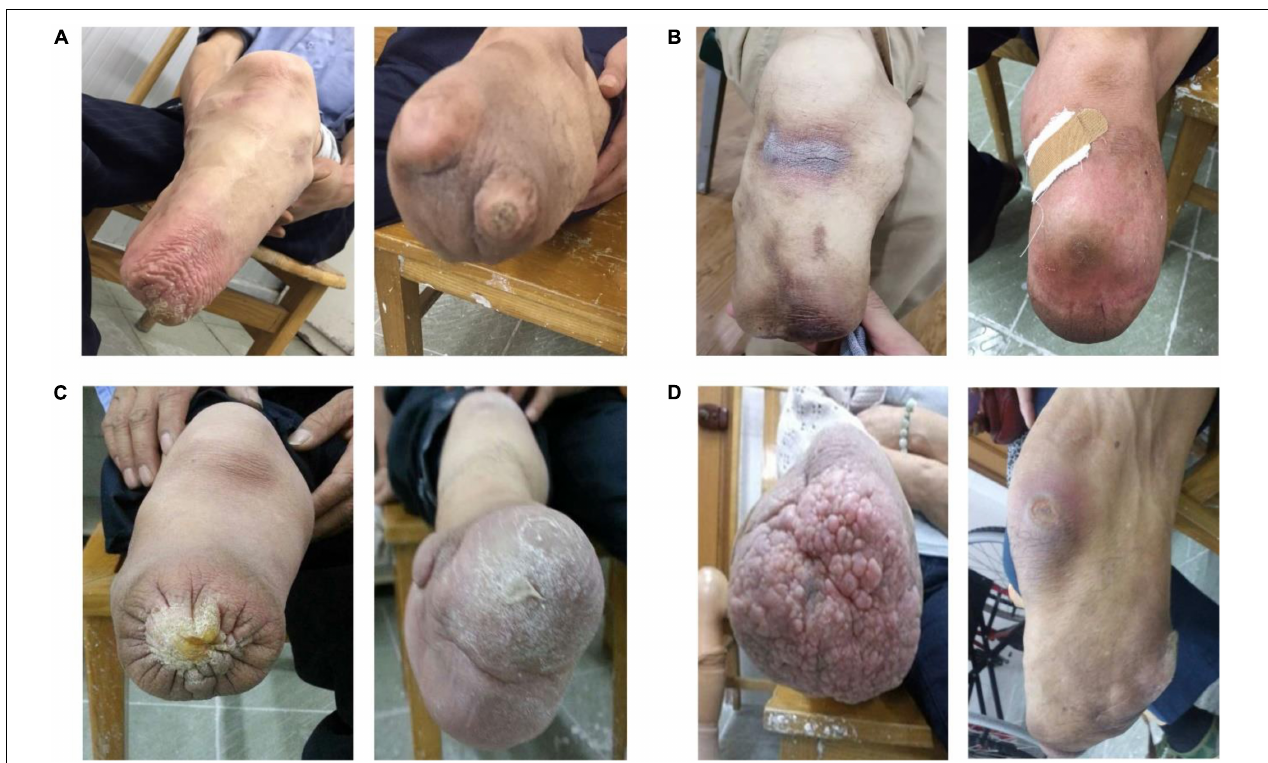
FIGURE 2 | Representative clinical lesion manifestations and patient distribution of ASSD. (A) Stump tinea corporis with fungal infection of Trichophyton rubrum (left) and Aspergillus (right). (B) Intertriginous dermatitis (left) and eczema (right). (C) Cutaneous keratosis. (D) Verrucous hyperplasia (left) and skin ulceration